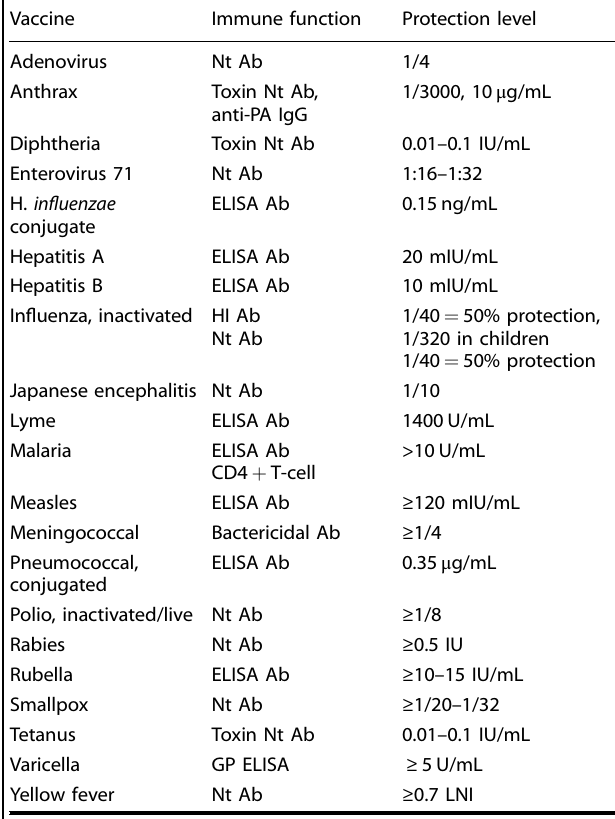
Table 1. Correlates of protection after vaccination 11 Vaccine Immune function Protection